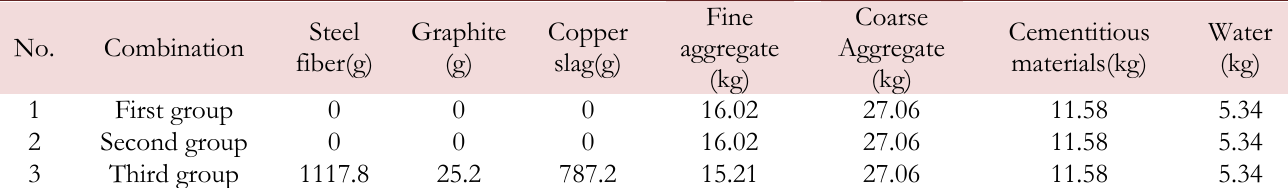
Table 6: Material ratios of the test piles.